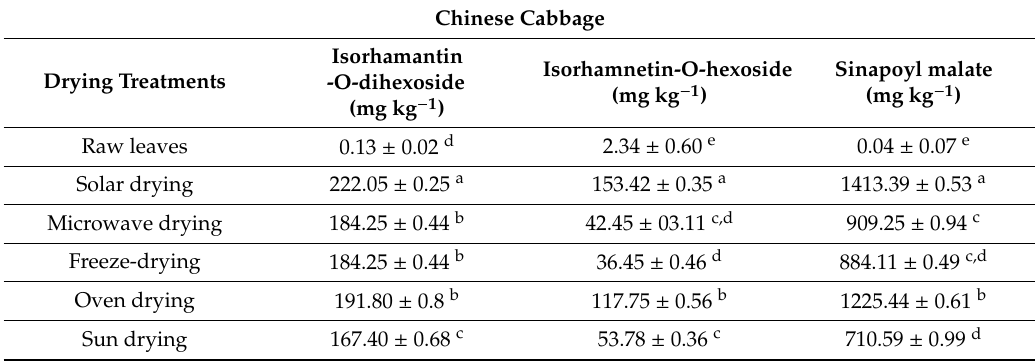
Table5. InfluenceofdryingtreatmentsonisorhamantinglycosidesandsinapoylmalateinChinesecabbage.